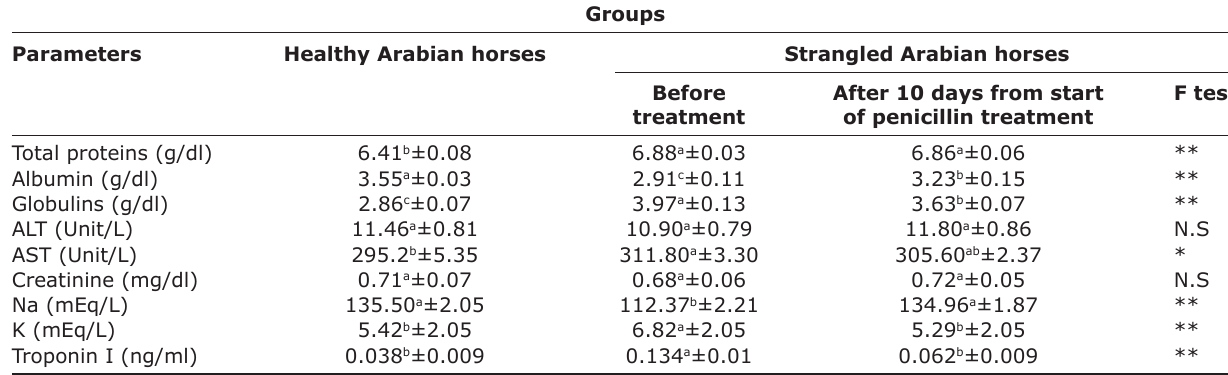
Table-4: Alteration in some biochemical parameters in Arabian horses naturally infected with S. equi during the disease after 10 days from penicillin treatment compared with the healthy horses (mean